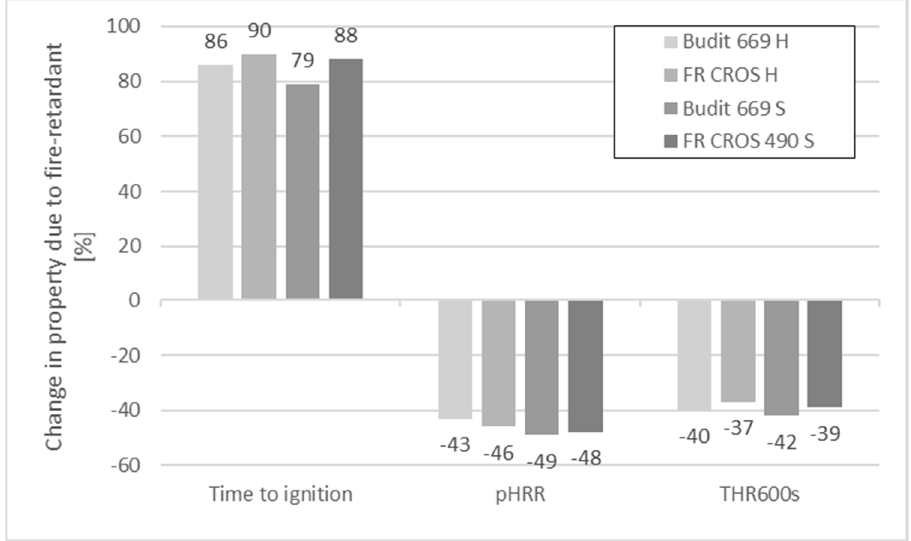
Figure 7. Change in time to ignition, peak heat release rate, and total heat release after 600s due to the fire-retardants in co-extruded profiles (before weathering). H: hollow-core profile; S: solid profile.